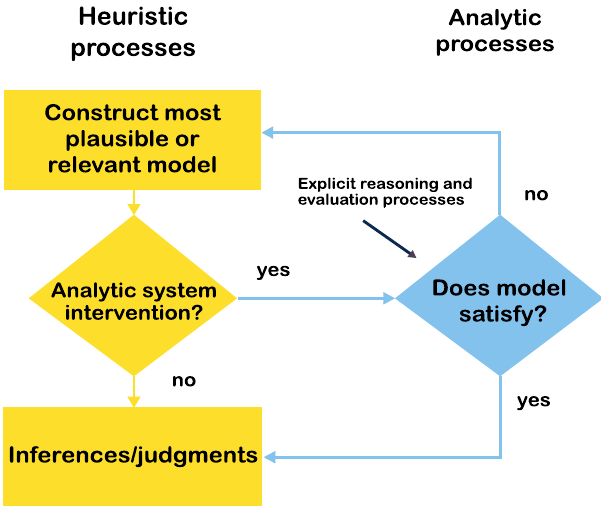
FIG. 3. Diagram showing the separate roles of the heuristic (type 1) and analytic (type 2) processes, taken from Ref.